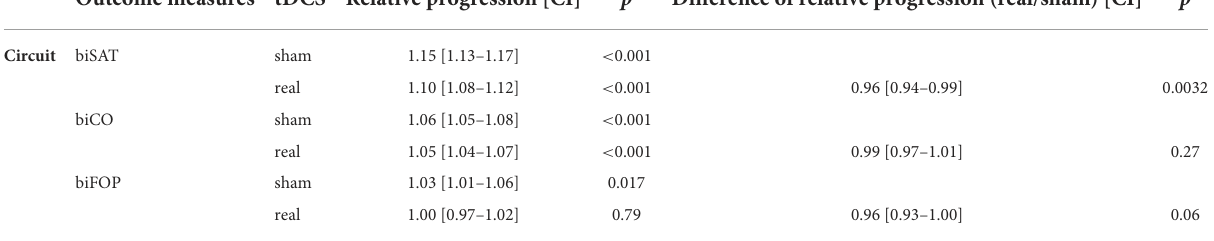
TABLE 2 Patients with stroke: Progression during training. Outcome measures tDCS Relative progression [CI]